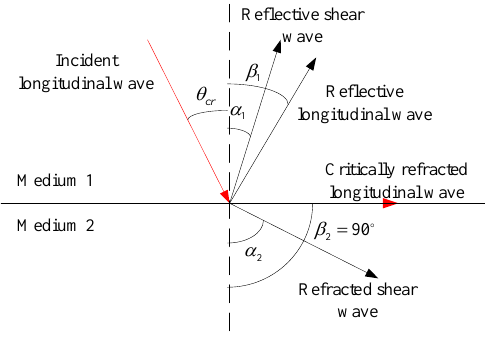
Figure 1. Wave conversion.